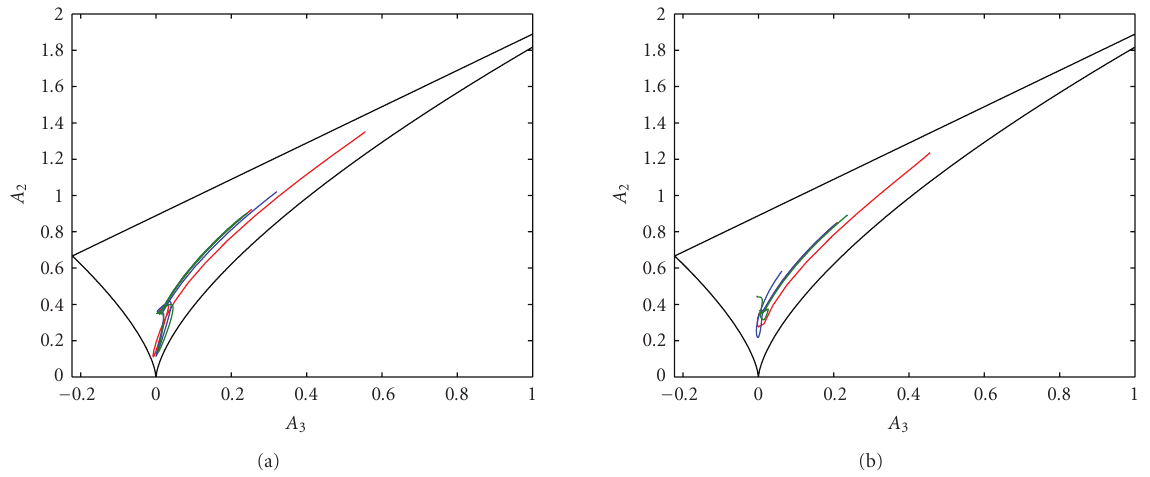
Figure 28: Anisotropy invariant map at (a) r ∗ = 0 . 3 and (b) r ∗ = 0 . 7 for Re = 10 6 , G = 0 . 02 and three flowrate coe ffi cients: C w = 2500 (red), C w = 5000 (blue), and C w = 10000